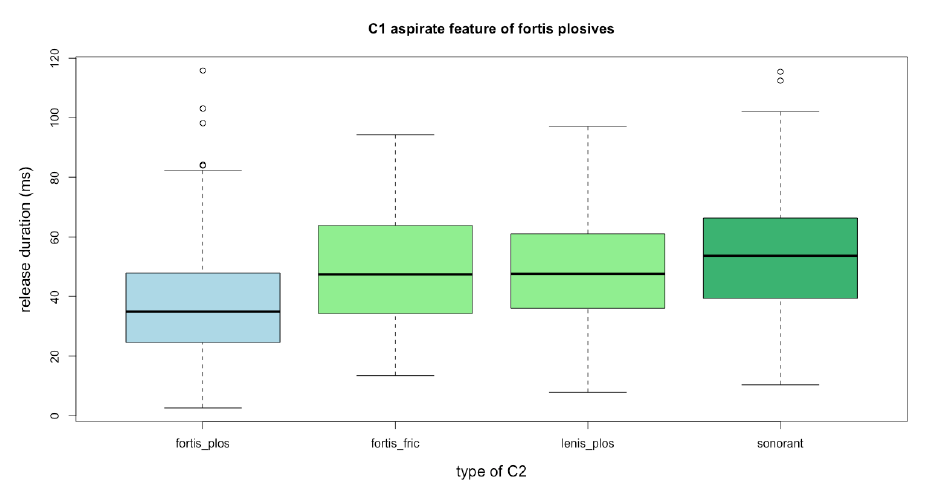
Figure 5: Effects of C₂ type on C₁ fortis plosive release duration, including /s/ in C₂